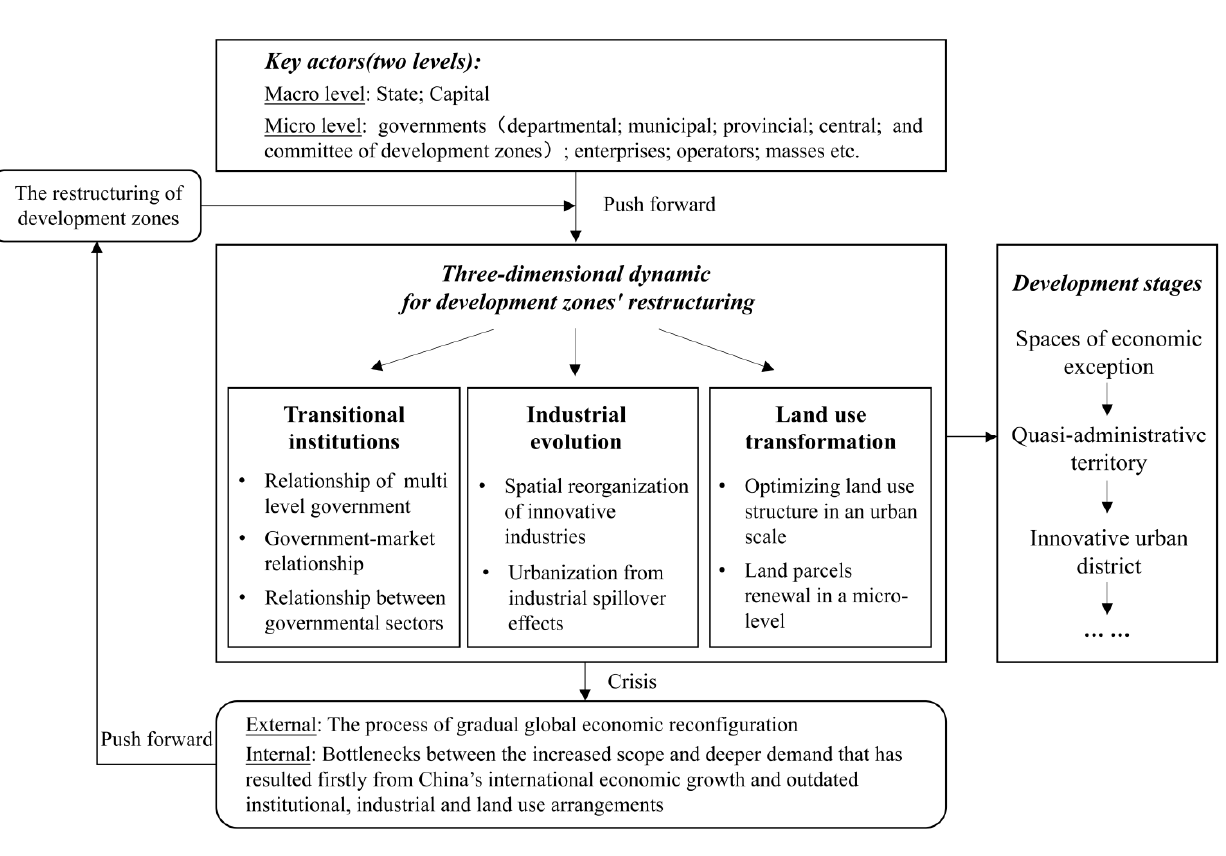
Figure 5. Dynamic framework for restructuring of development zones. Source: Prepared by the au- thors.